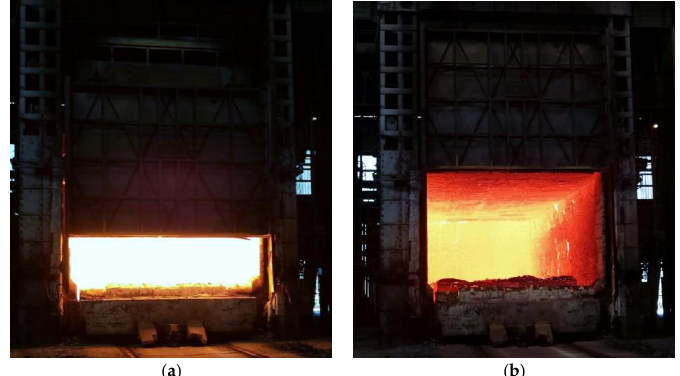
Figure 12. Pictures taken during the experimental test made in SdF: ( a ) The picture is related to a partial opening at 60 s; ( b ) The picture is related to a complete opening at 157 s.